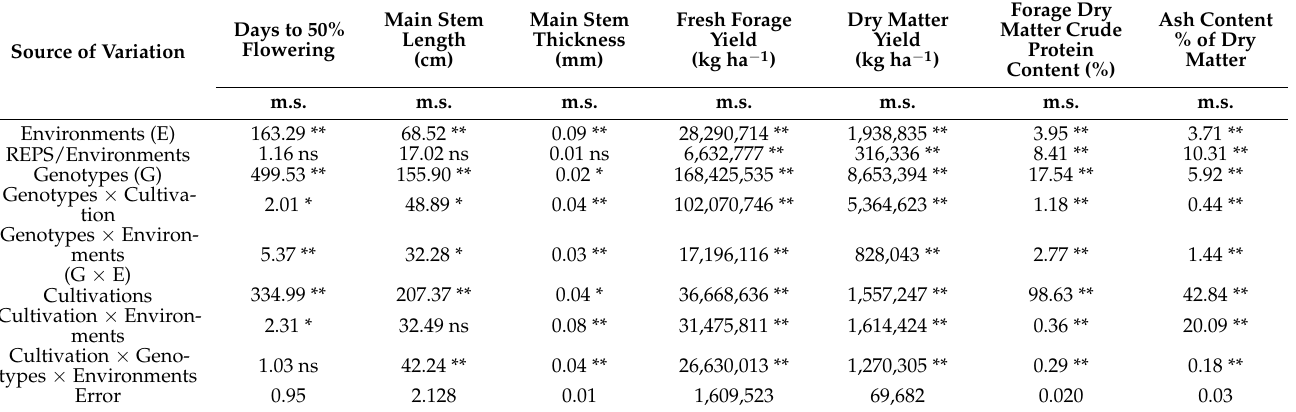
Table 1. Mean squares (m.s.) from analysis of variance over environments and cultivation methods for tested traits: days to 50% flowering, main stem length (cm), main stem thickness (mm), fresh forage yield (kg ha − 1 ), dry matter yield (kg ha − 1 ), forage dry matter crude protein content (%), and ash content % of dry